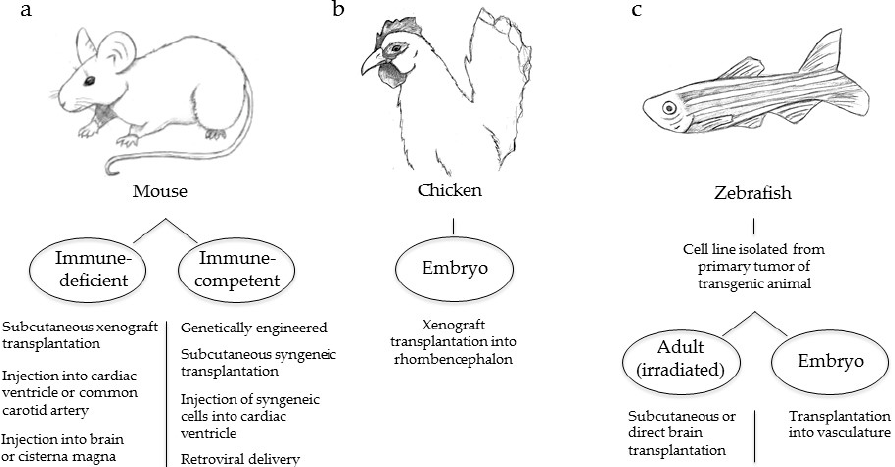
Figure 2. Animal models used to investigate melanoma brain metastasis. ( a ) Immunodeficient and immunocompetent mouse models; ( b ) Chicken embryo model; ( c ) Zebrafish adult and embryo models.